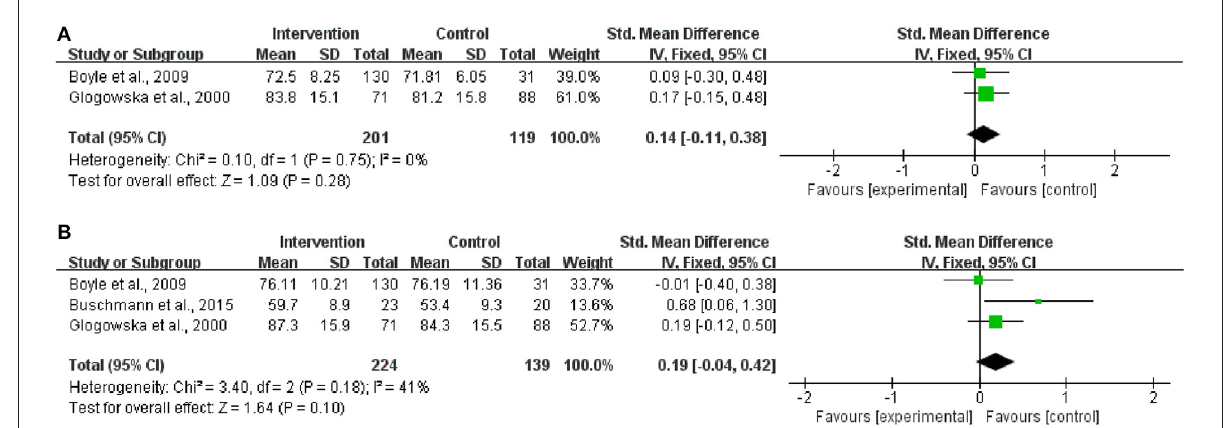
FIGURE7 Meta-analysis outcomes of the long-term effect of the intervention on overall expressive and receptive language development. (A) Overall expressive language development; (B) Overall receptive language development. Control, no or delayed intervention.